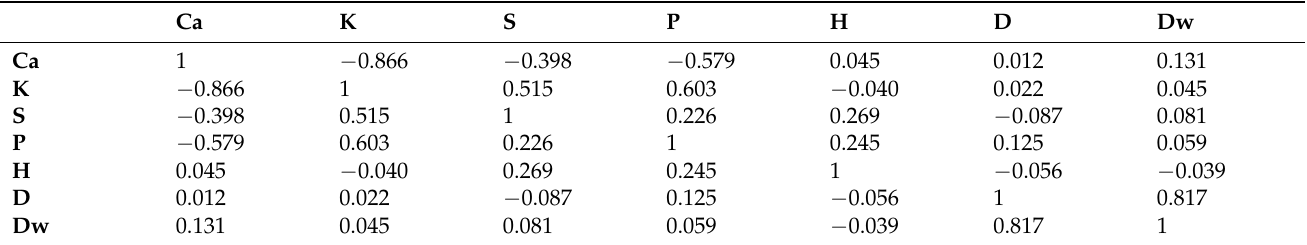
Table 2. Pearson’s correlation between Ca, K, S, P, height, diameter, and dry weight content in tubers after the last foliar application for the Picasso variety. Height (H); Diameter (D) and Dry weight (Dw).